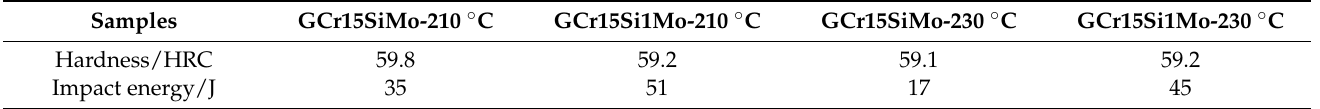
Table 3. Hardness and impact toughness of the steels austempered at different